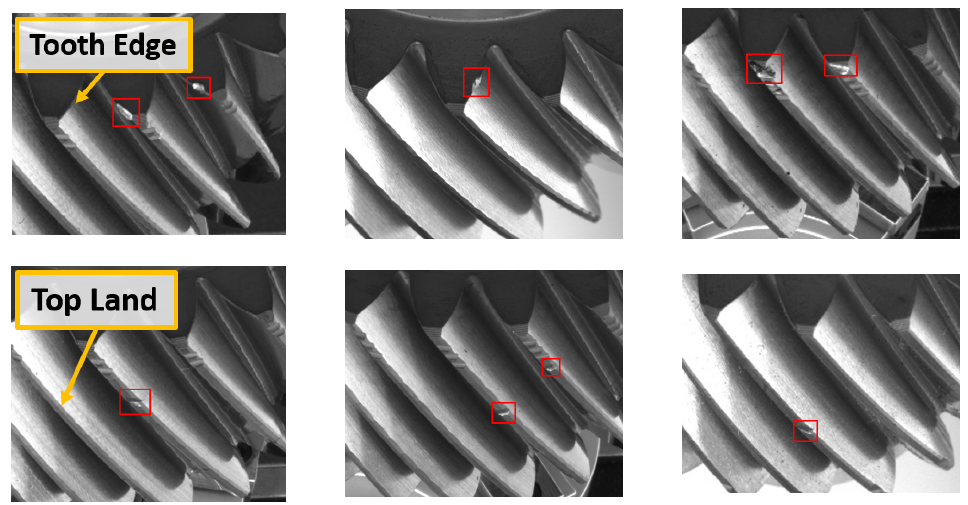
Figure 1. Damaged Teeth defect on the Tooth Edge ( top row), and Top Land ( bottom